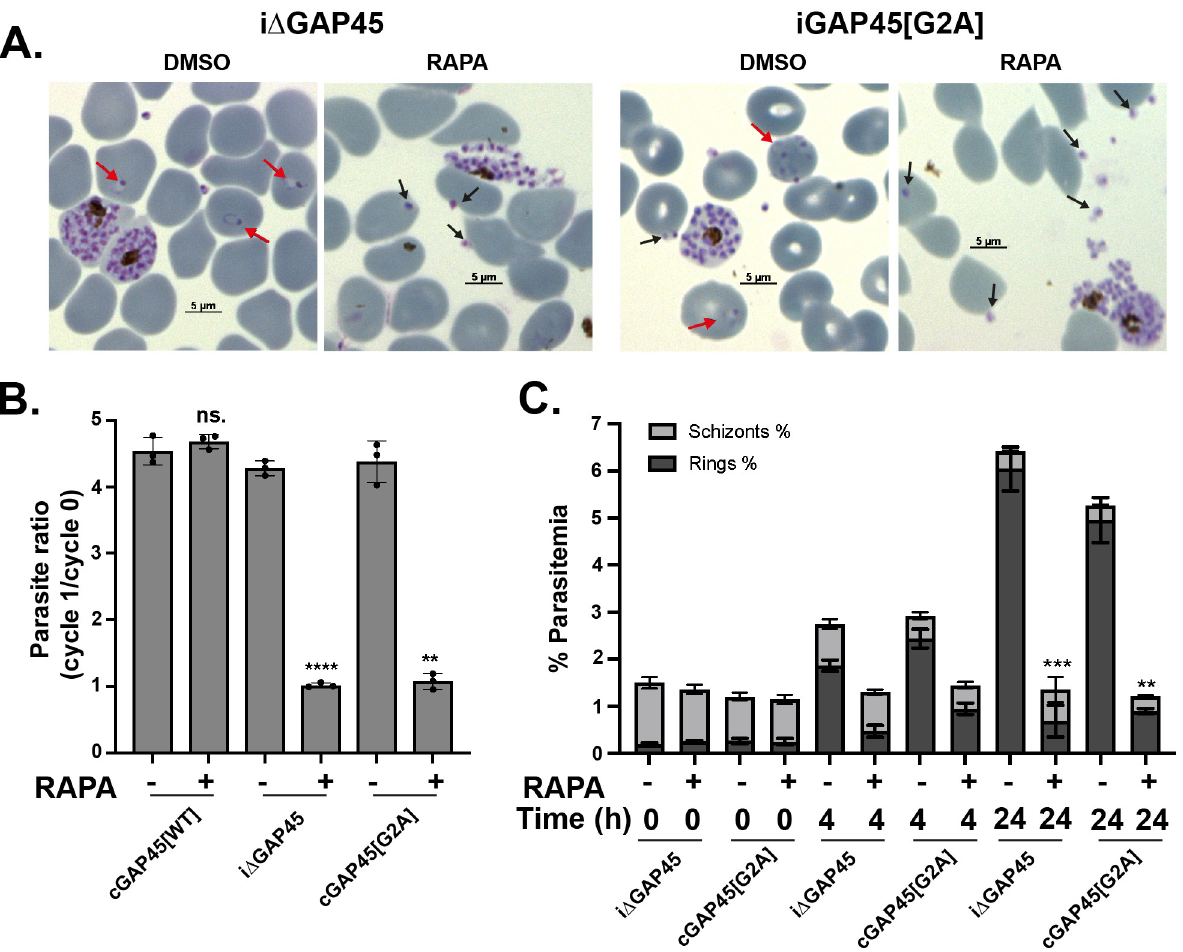
Fig 8. Parasites expressing GAP45[G2A] are not blocked at egress but show a defect in invasion. (A) Giemsa-stained thin blood smears of gap45 : ha3 : loxP (i Δ GAP45) and gap45 : ha3 : loxP :: comp_gap45[G2A] (cGAP45[G2A]) clones treated with DMSO or rapamycin, showing the substantial reduction in newly invaded ring stages after rapamycin treatment in both lines, while invasion occurs in the DMSO control (red arrows). Despite little invasion after rapamycin treatment, there is an abundance of extracellular merozoites visible with some apparently attached to erythrocytes (black arrows) indicating egress had occurred. (B) Invasion assay of gap45 : ha3 : loxP :: comp_gap45[WT] (cGAP45[WT]), gap45 : ha3 :loxP (i Δ GAP45), and gap45 : ha3 : loxP :: comp_gap45[G2A] (cGAP45[G2A]) and showing the parasite ratio (parasitemia of cycle 1 / parasitemia of cycle 0) with and without rapamycin treatment. Data are from 3 biological replicates, each in triplicate (see S1 Data), Welch unpaired 2 tailed p < 0.0001 [ ���� ] for i Δ GAP45, p = 0.001 [ �� ] for cGAP45[G2A] and not significant [ns.] for cGAP45[WT]); error bars show standard deviation. (C) Percentage parasitemia of schizonts and rings in gap45 : ha3 :loxP (i Δ GAP45) and gap45 : ha3 : loxP :: comp_gap45[G2A] (cGAP45[G2A]) parasites at 0, 4, and 24 hours after culture of schizonts grown in the presence of DMSO or rapamycin. Data are from 3 biological replicates, each in triplicate with 2 independent clones (see S1 Data), Welch unpaired 2 tailed t test p < 0.0002 [ ��� ] for i Δ GAP45 and p = 0.0042 [ �� ] for cGAP45[G2A]); error bars show standard deviation. GAP45, glideosome-associated protein 45; WT,